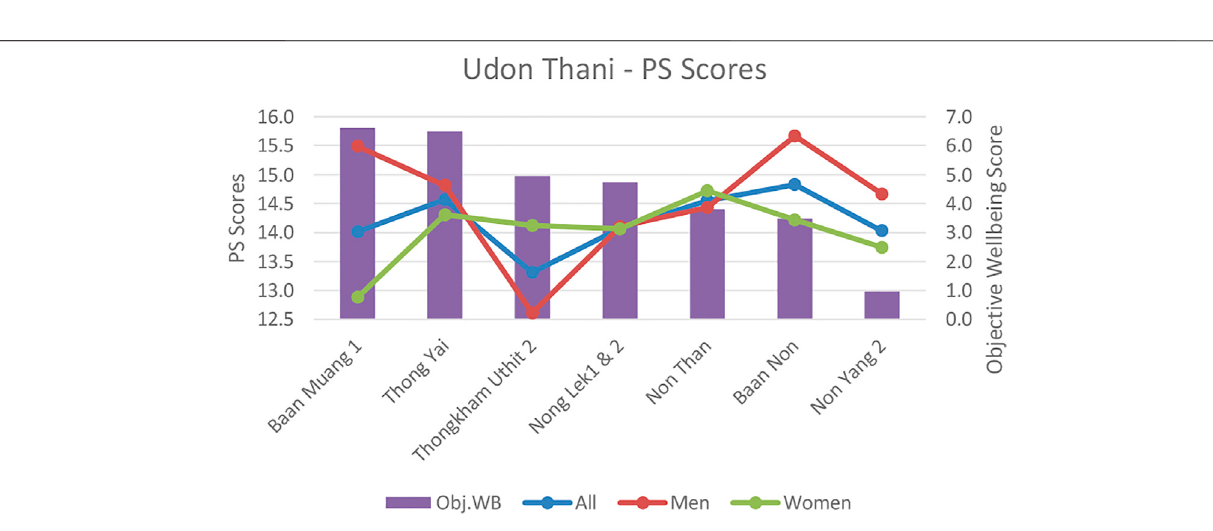
Frontiers in Sociology |